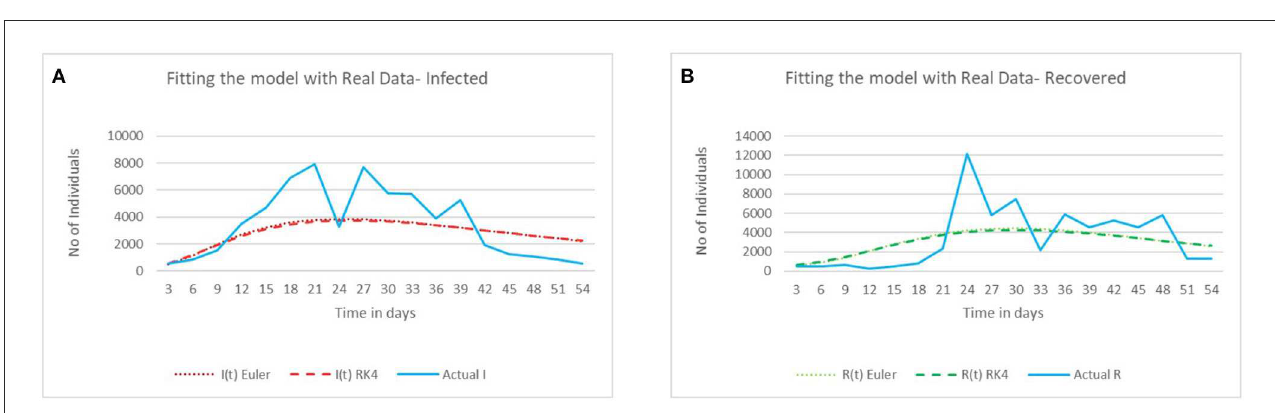
recovered populations. Furthermore, Supplementary Table 8